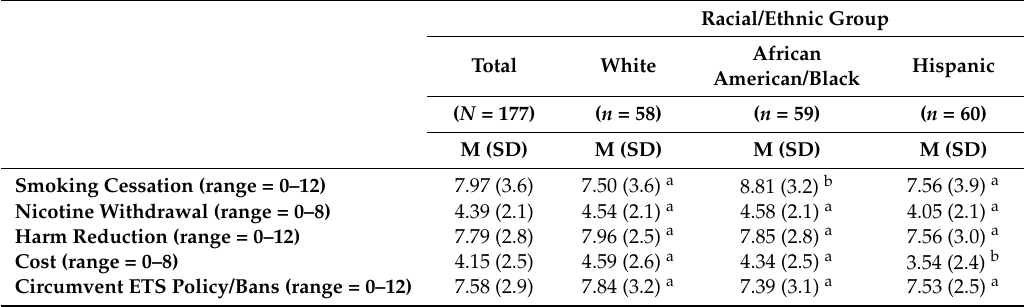
Table 4. Reasons for E-Cigarette Use among Ever-Users by Racial/Ethnic